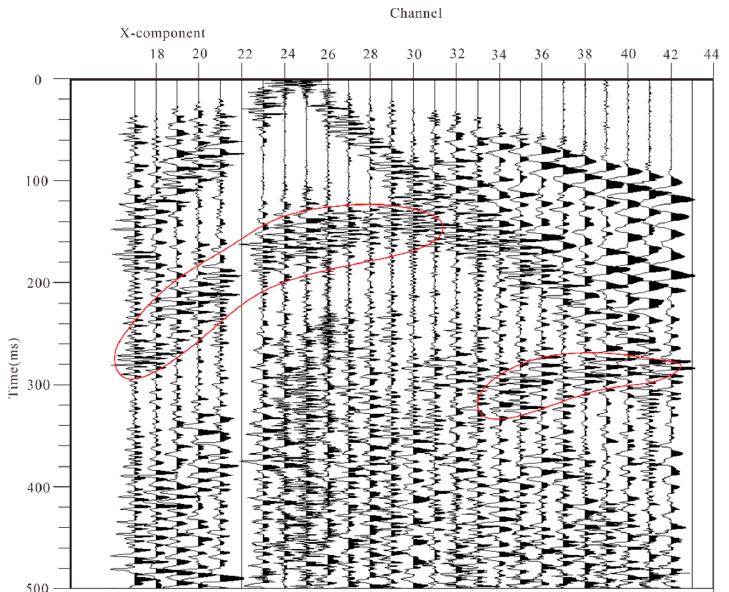
Figure 3. Seismic reflection record for S7. The reflected wave groups is circled in red.